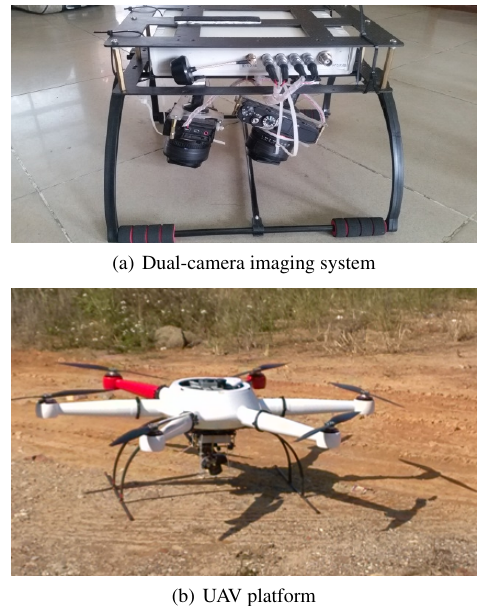
Figure 1. The workflow for 3D model reconstruction of transmission line. Figure 2. Oblique photogrammetric system.